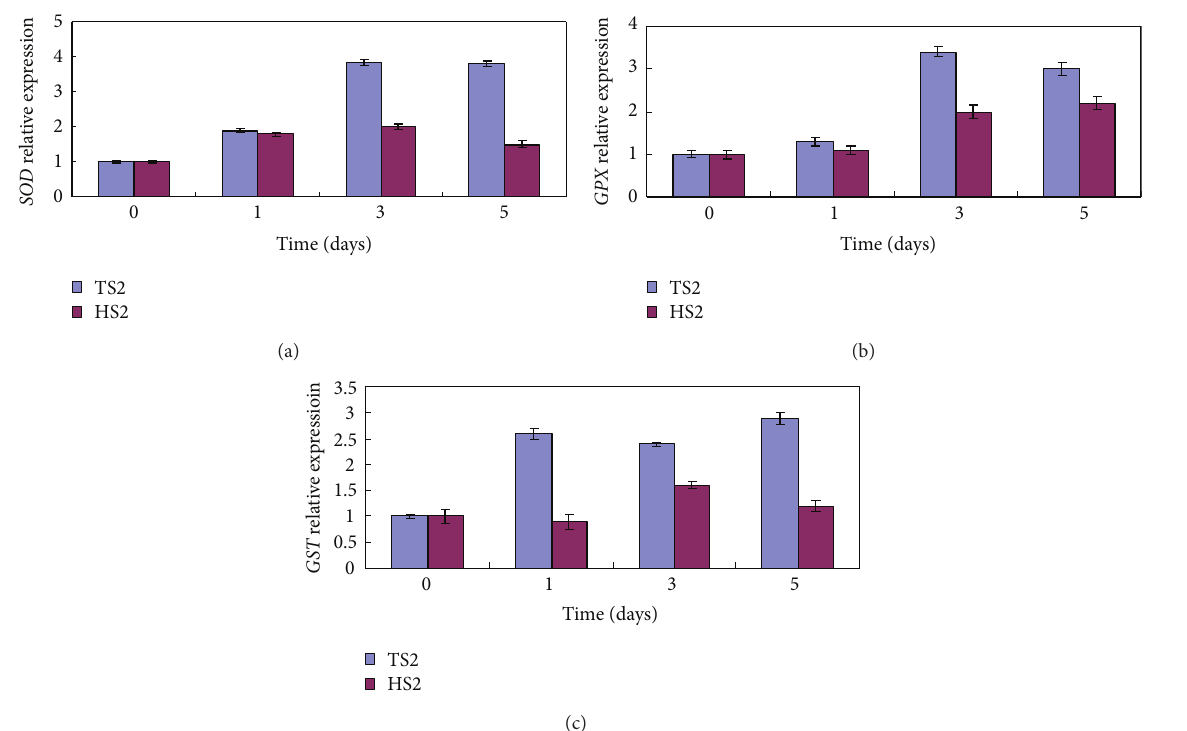
Figure 6: Comparisons of (a) SOD , (b) GPX, and (c) GST expression levels in HS2 and TS2 plantlet after transplantation in a simple shed covered with a 50% sunshade net by